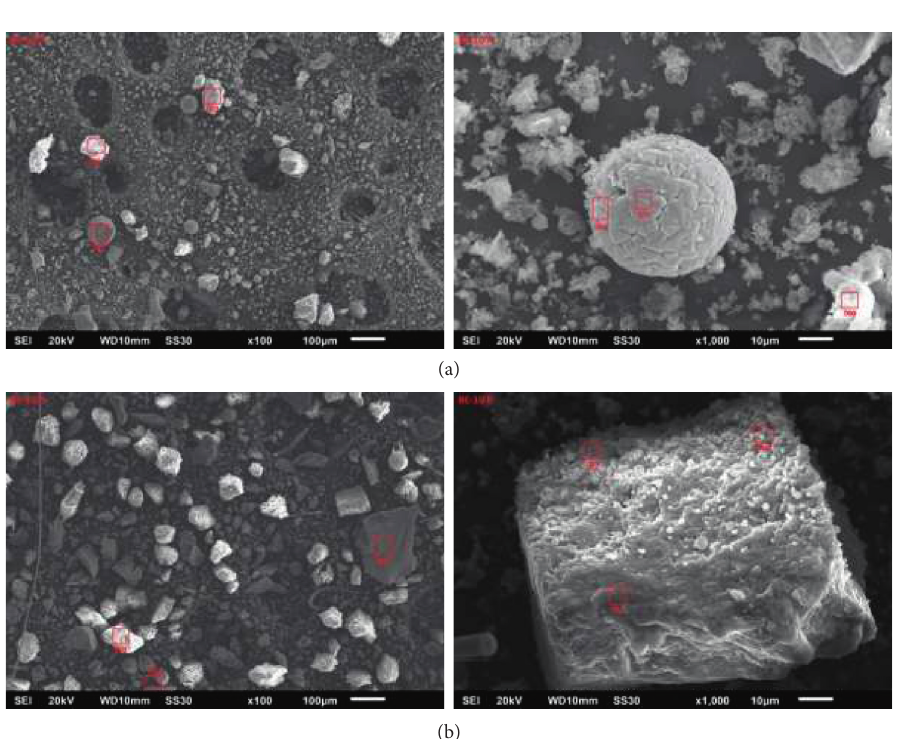
Figure 5: Comparison of 100x and 1,000x Magnification of BD-2B at (a) 550 ° C and (b) 600 ° C.